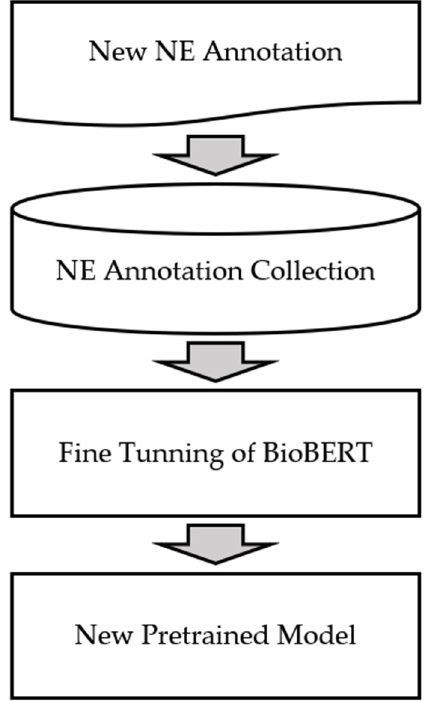
Figure 1. Structure of tagging tool.